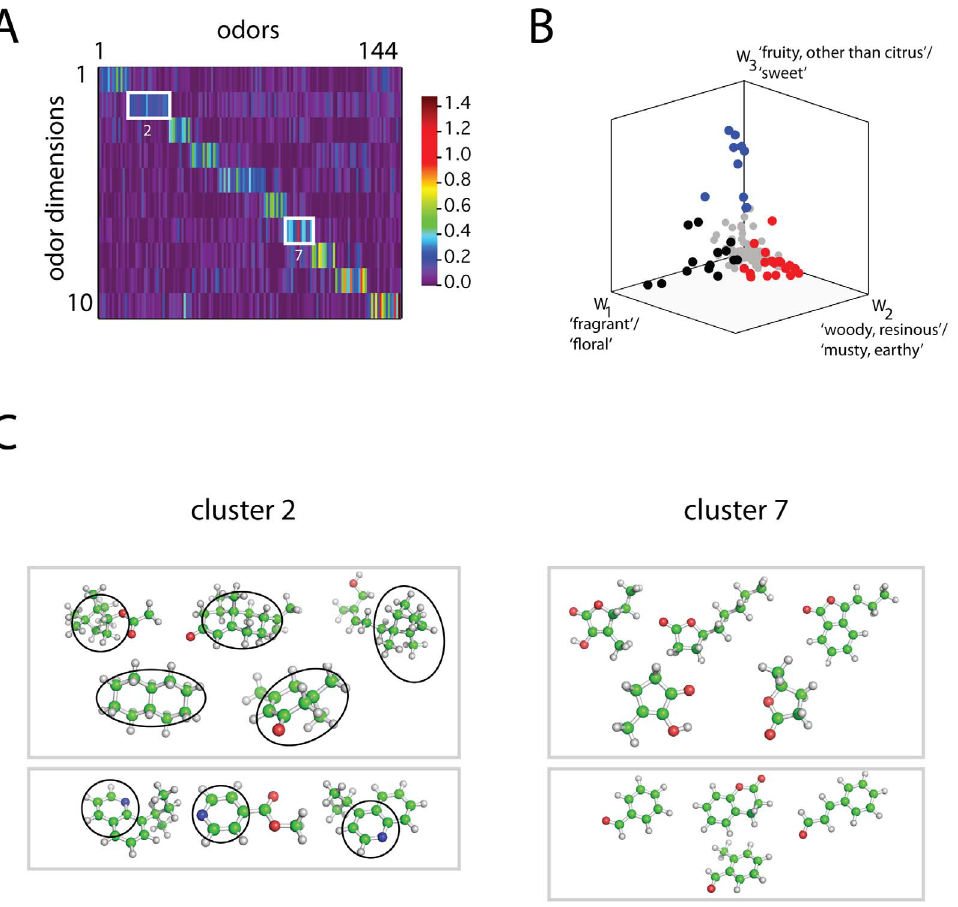
Figure 6. Visualization of odors expressed in coordinates of the new basis. A ð Þ The weight matrix, H , discovered by NMF. Columns of H (each column corresponds to a different odor), are normalized and sorted into groups defined by peak coordinate (1–10). B ð Þ Plot of all 144 odors (each point is a column of H ) in the space spanned by the first 3 basis vectors, W 1 , W 2 , and W 3 . Black, red, and blue points are those with peak coordinates in dimensions 1, 2, and 3 respectively. Gray points are all remaining odors. C ð Þ Chemical structures of representative odorants from the second and seventh diagonal blocks of the sorted matrix H (panel A ð Þ ).